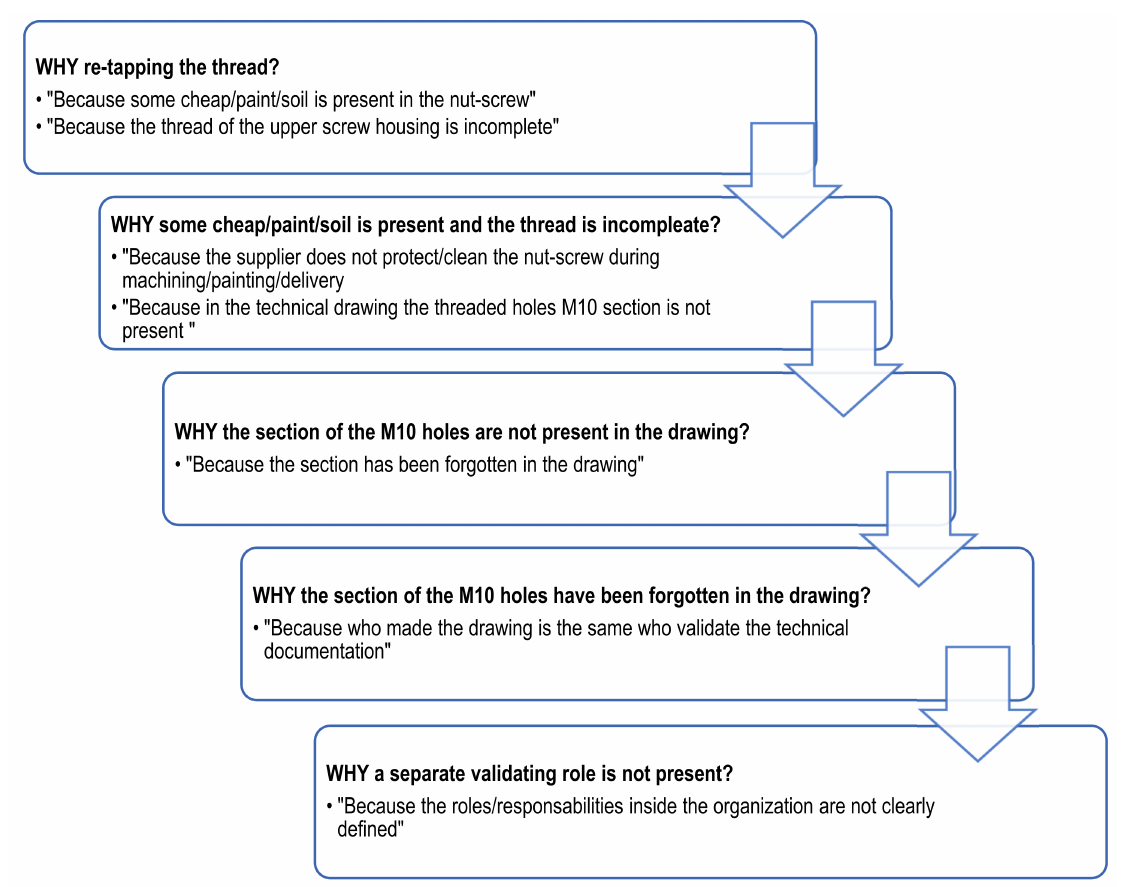
Figure 5. The lean 5 whys tool, applied. The answers collected during the interview sessions are shown below each